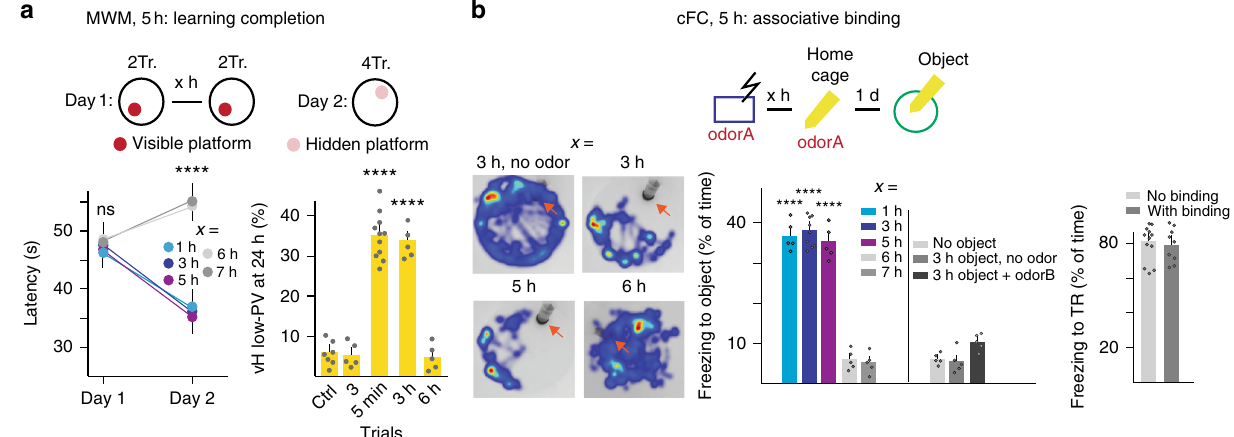
Fig. 1 A 5 h time window for learning and associative binding. a Time window to complete MWM learning. Left: latencies as a function of time interval between fi rst and second group of two trials on Day1. Two-way RM ANOVA, Interaction, P < 0.0001, n = 5, 8, 5, 5, 5; right: PV plasticity (low-PV contents in vH at 24 h; Ctrl: swim control without platform); One-way ANOVA, P < 0.0001, n = 7, 5, 11, 5, 5. Tr. trial, x numbers of hours as indicated in different protocols; Day2: 4 trials. b Associative binding of neutral object to fear memory during 5 h time unit. x number of hours following acquisition of cFC. Schematic: boxes of different colors indicate different contexts; object: Falcon tube. Left, center: Representative heat maps (left) and quantitative analysis (center; one-way ANOVA, P < 0.0001, n = 5, 9, 5, 5, 5, 5, 5, 5) of novel context exploration in the presence of object (Falcon tube; orange arrows). Right: Fear memory binding (3 h after acquisition) does not in fl uence fear response to conditioning context (tested at 26 h; unpaired t -test, t (19) = 0.8568, P = 0.4022, ns, n = 12, 9). Error bars: SEM; P < 0.05 (*), 0.01 (**), 0.001 (***), 0.0001 (****). For a more detailed description of the statistical